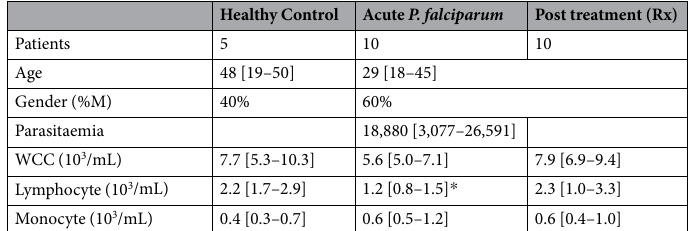
Table 2. Acute malaria cohort. Values show the median and [interquartile range]. Comparison between healthy controls and acute malaria was performed using a Mann-Whitney t-test, * p ≤